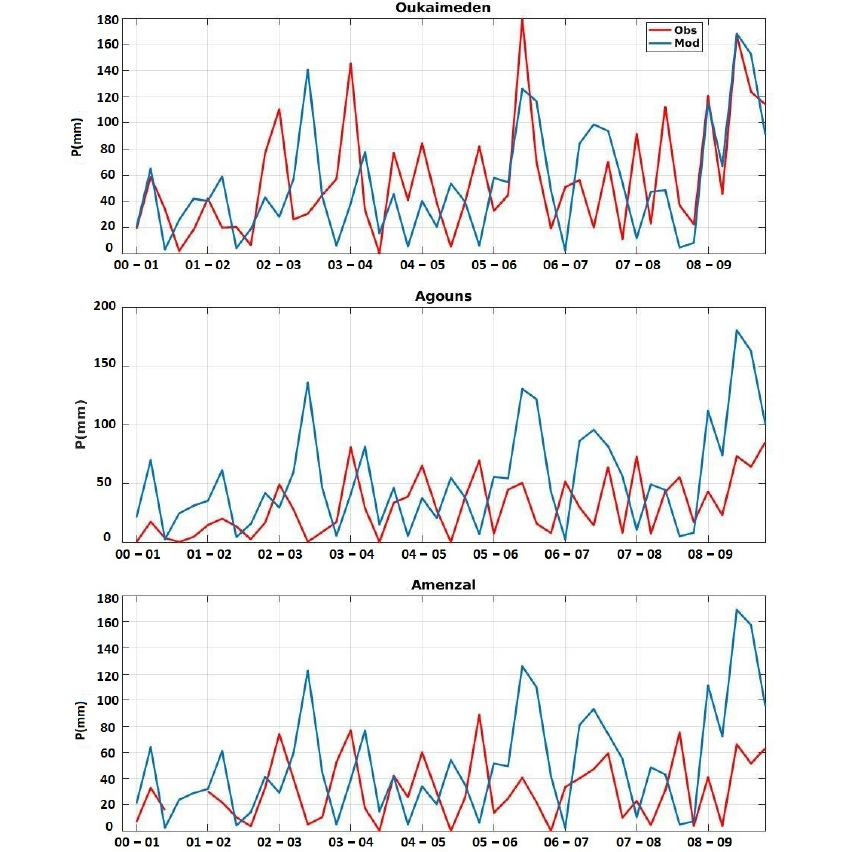
Figure 7. Evolution of monthly precipitation between 1 December and 1 April from rain gauge measurements (Obs: refers to observed) and MERRA-2/MicroMet (Mod: refers to